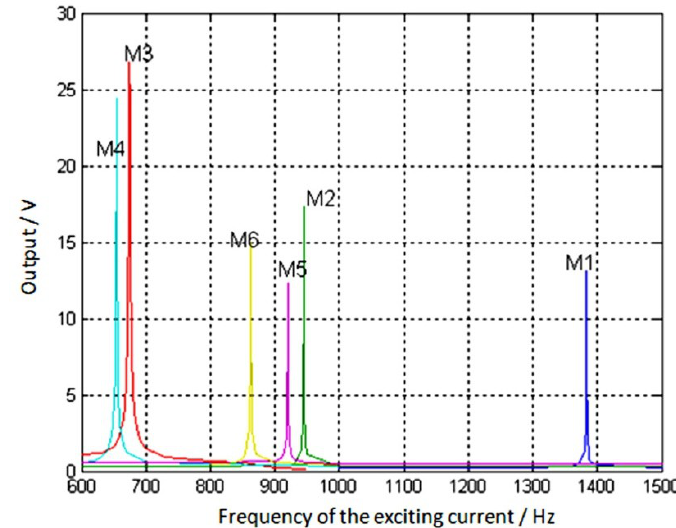
Figure 8. Frequency characteristics of the exciting current for different samples. Reproduced with permission from [29], published by IEEE, 2013.